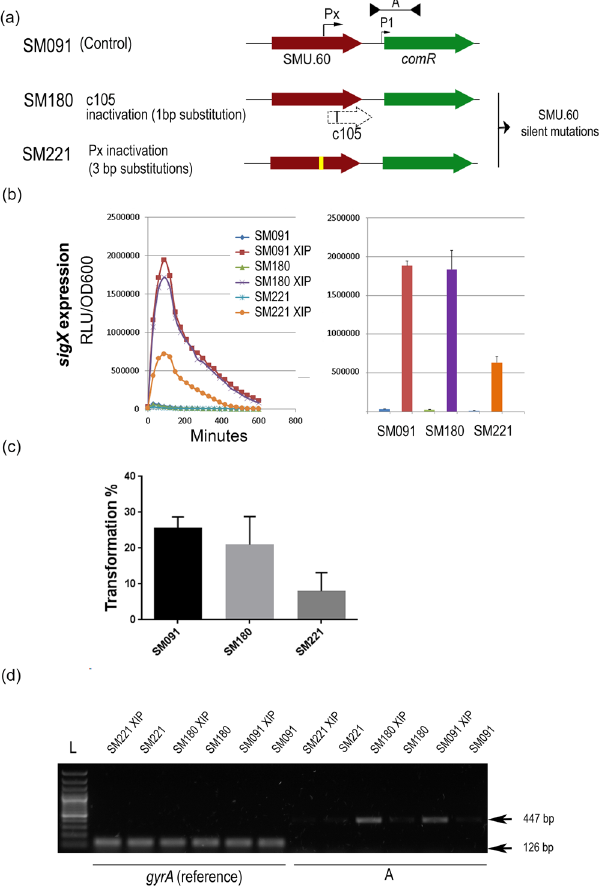
Figure 6. Effect of single base mutations upstream of comR on sigX expression, competence, and comR transcript length. ( a ) Map of the SMU.60 intragenic region with a putative promoter containing a σ x-box (Px) and the downstream predicted comR promoter closest to the start of the comR gene (P1). The A region corresponds to the PCR fragment amplified by the primer pair FP785 and FP1200. The S. mutans strains used were all Δ comS , SigX-luciferase reporters: SM091, wild type background; SM221, mutant with an inactivated σ x-box (yellow vertical box); SM180, mutant with a stop codon (black vertical line) within a possible alternative open reading frame (ORF; dashed arrow) overlapping with part of the SMU.60 gene. ( b ) sigX expression with and without addition of XIP in CDM. Luciferase activity measured in the presence of luciferin is presented as relative light units (RLU) per OD600. Left panel: Kinetic results representative of three independent experiments. Right panel: Average from three independent experiments at 100 min. Bars represent standard deviation. ( c ) Transformation efficiency using the 6,3 Kb amplicon aRJ02 as donor DNA. The results are averages of 3 independent experiments. Bars represent standard deviations. ( d ) Gel image showing cDNA amplification in the A region of the WT and SM180 in the presence of XIP. The A transcript was not detected in SM221. Primers FP785 and FP1200 were used to amplify A (447 bp), and FP299 and FP300 to amplify gyrA (126 bp; reference). L; 1Kb Plus DNA ladder